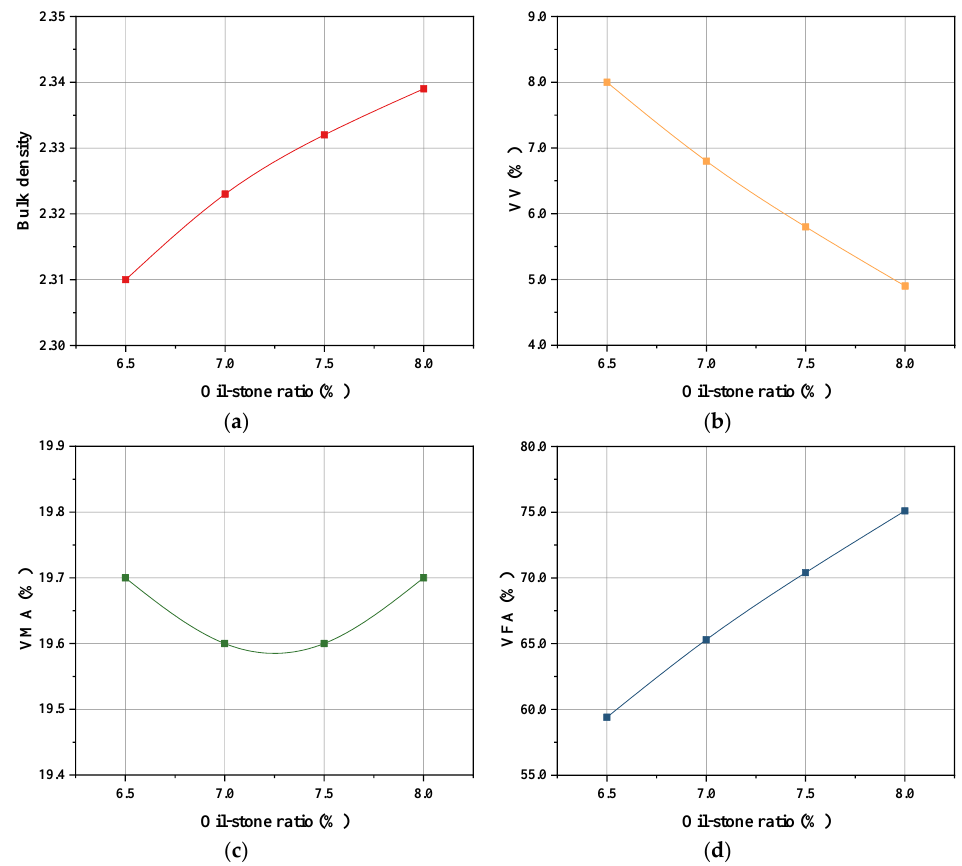
Figure 14. Blk density ( a ); VV ( b ); VMA ( c ); VFA ( d ) under different oil–stone ratios. Table 5. Oil–stone ratio design inspection results.